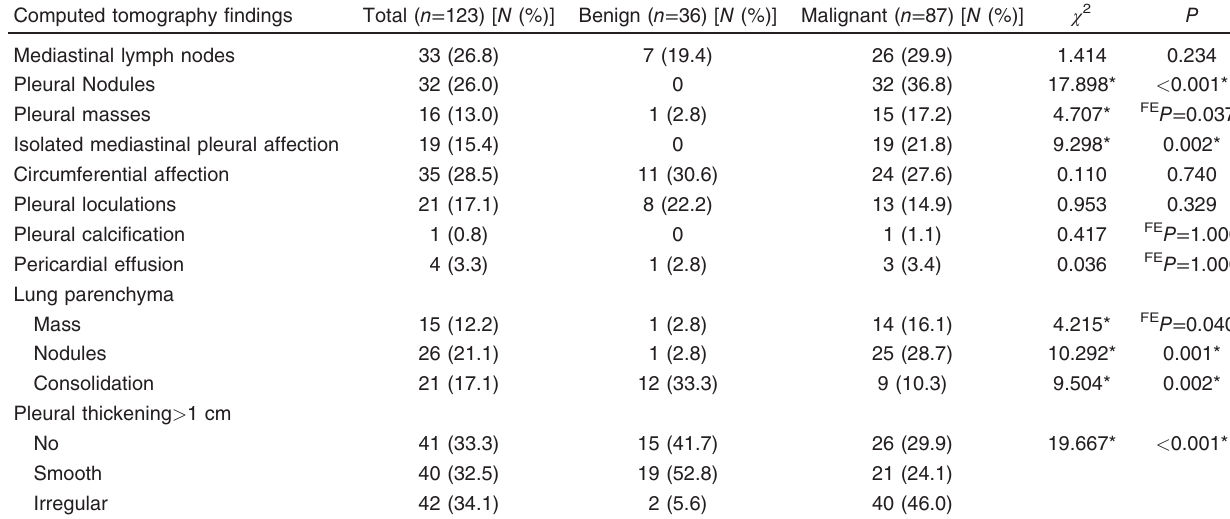
Table 3 Comparison between the two groups studied according to computed tomography findings Computed tomography findings